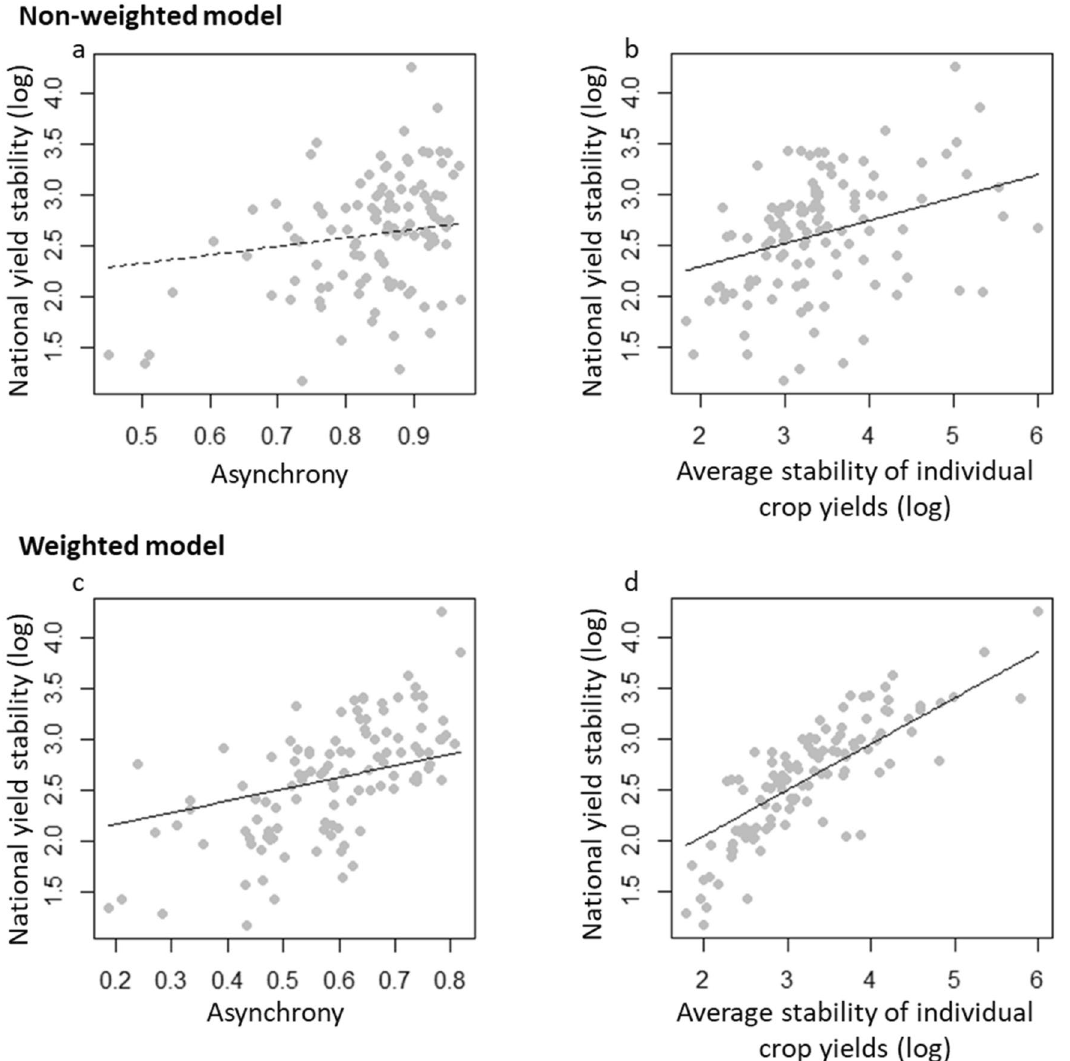
Figure 2. Effects of the average stability of individual crop yield and asynchrony on total, national yield stability. Black lines show the relationships estimated by the structural equation model when the crop yields are non-weighted ( a , b ) and weighted ( c , d ) by the proportion of cropland occupied by each crop within a country. Dashed lines represents non significant